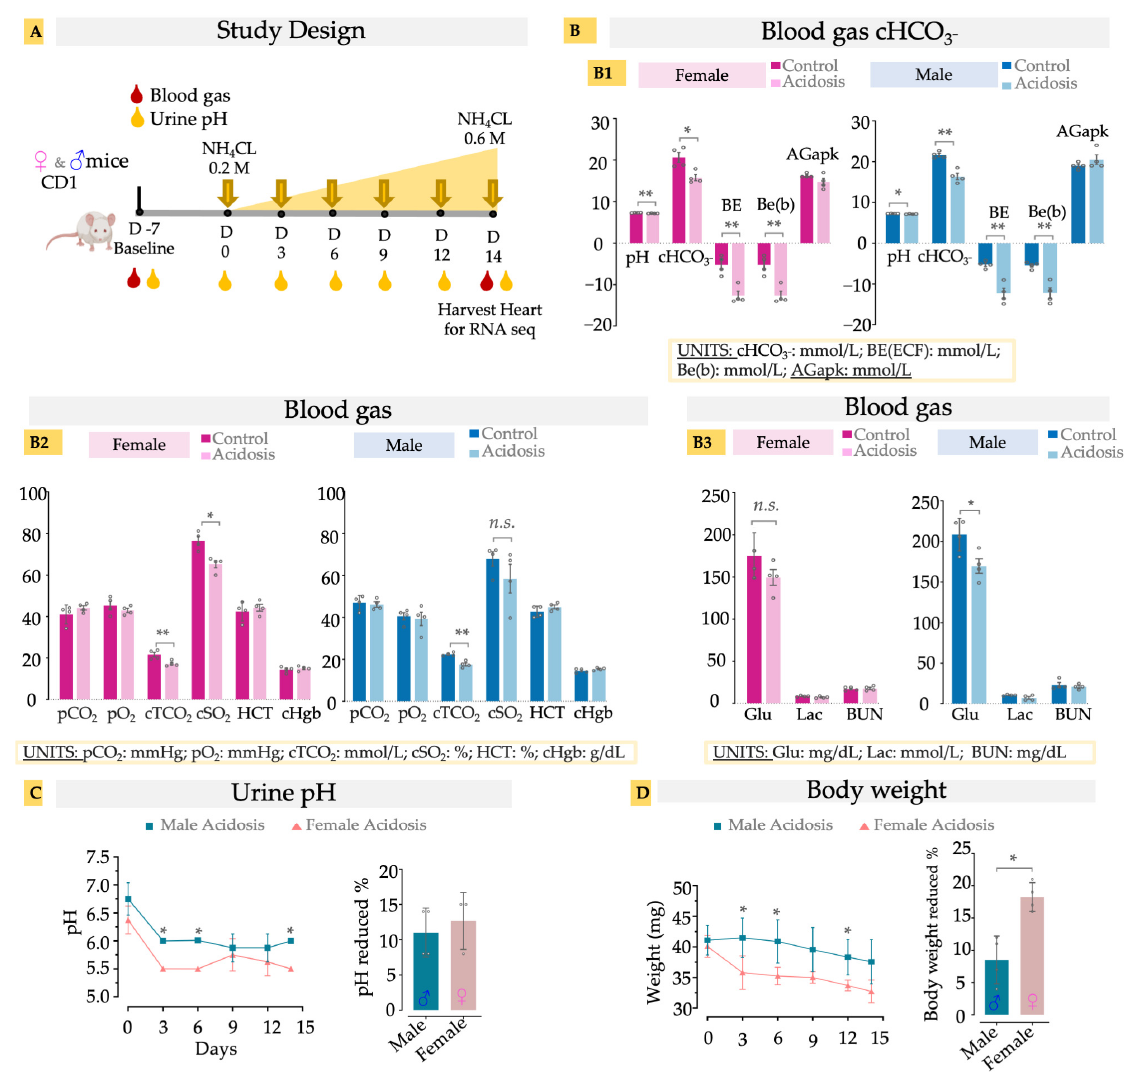
Figure 1. ( A ) Schematic of study design. Oral administration of NH 4 Cl, using stepwise dosing increase, induces murine acidosis. Urine pH was measured at baseline (D-7), D0, D3, D6, D9, D12, and D14. Blood gas was measured at baseline (D-7) and D14 for both control (n = 4) and acidosis (n = 4) groups. ( B ) Blood gas measurement. B1 , pH, HCO 3- , BE, Be(b) and AGapK levels in the blood; B2 , pCO 2 , pO 2 , cTCO 2 , cSO 2, cHgb, Hct level in blood; B3 , Glu, lac and BUN level in blood. ( C ) urine pH, ( D ) body weight. Two tailed student’s t -test was used to determine di ff erences between acidosis and control. * < 0.05; ** < 0.01, n.s. (non-signi fi cant). Actual bicarbonate (cHCO 3 − ; mmol/L), base excess of extracellular fluid (BE(ecf); mmol/L), base excess of blood (BE(b); mmol/L), Anion gap (AGapK, mmol/L), Carbon dioxide partial pressure (pCO 2 ; mmHg), oxygen partial pressure (pO 2 ; mmHg), total carbon dioxide (cTCO 2 ; mmol/L), oxygen saturation (cSO 2 ; %), hematocrit (Hct; %PCV), hemoglobin (cHgb; %), Glucose (Glu; mg/dL), lactate (Lac; mmol/L), Blood urea nitrogen (BUN;